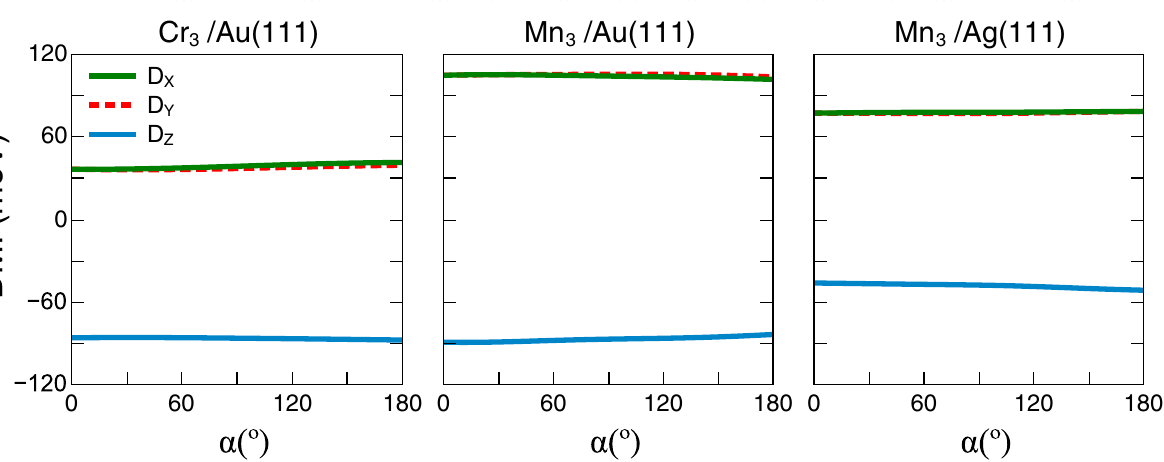
Figure 4. Scaling of the strength of the SOC calculated for a Néel like magnetic structure, with a fixed value of 60 angle between atomic moments and the z-axis θ ◦ . On the left panel we show results for the Cr triangular = trimer on Au(111), the middle panel contains results for the the triangular trimer of Mn on Au(111) and on the right panel we show data for the Mn triangular trimer on Ag(111). The blue line denotes the D z component D y . while the red line denotes the in-plane components D x =